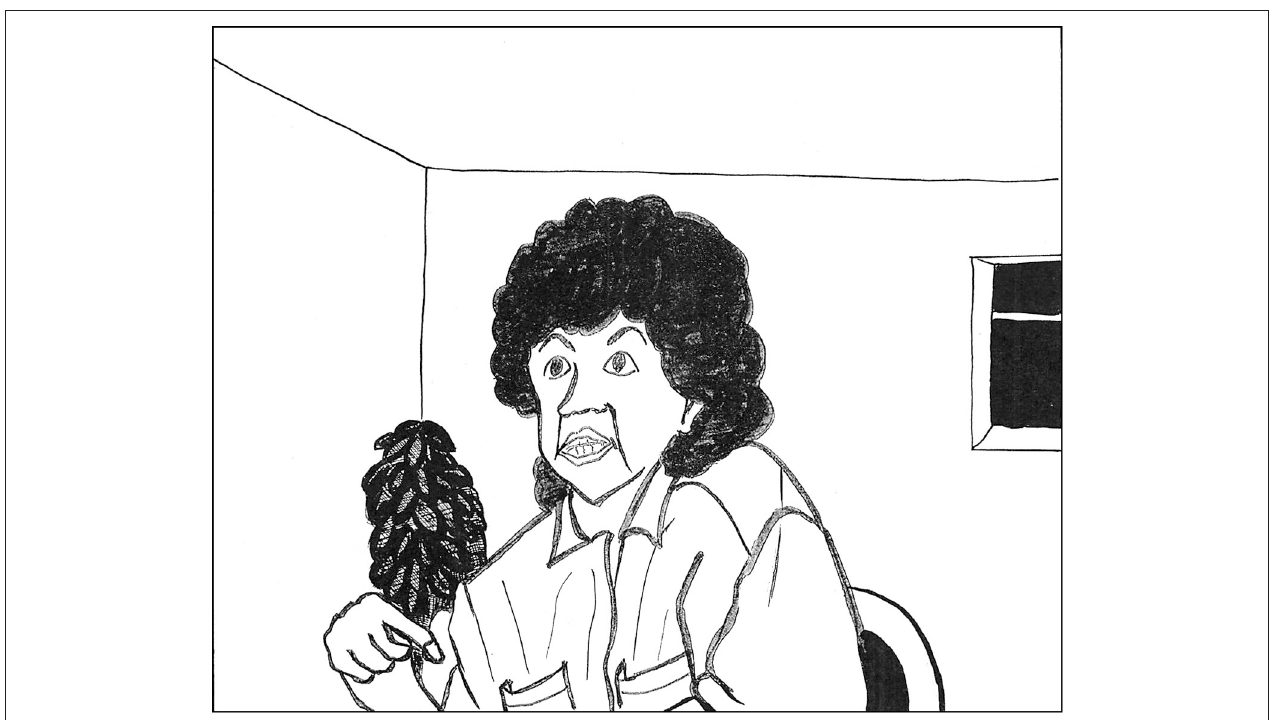
FIGURE 1 | Schematic illustration of stimuli: frame presenting a passenger claiming the loss of luggage to a hostess. Actual stimuli were real-life dynamic